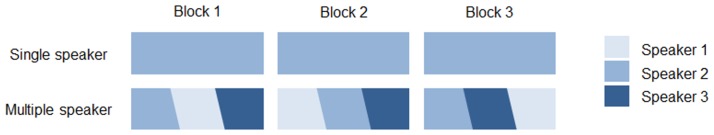
Example training regimes for participants in the single and multiple speaker conditions.